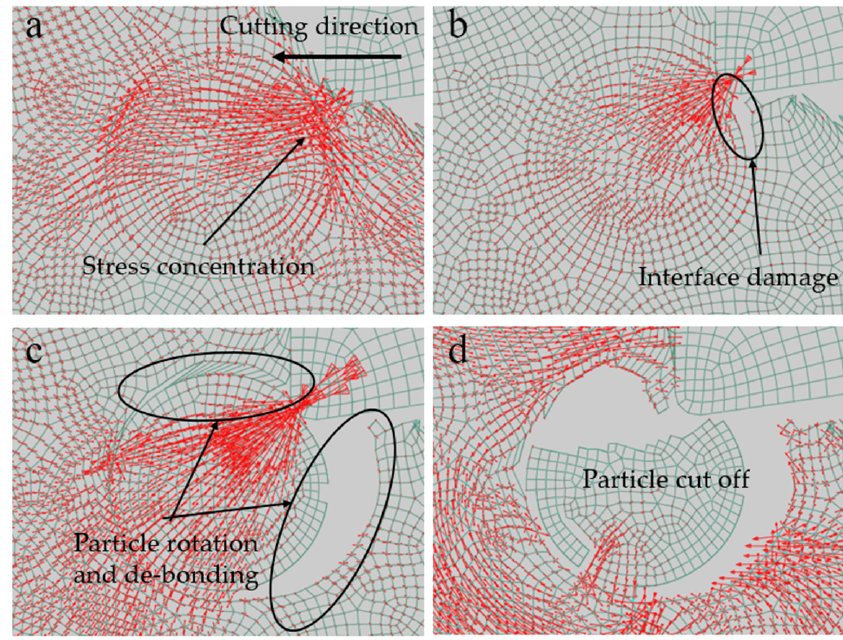
Figure 13. Stress evolution of UEVCT particle removal process. ( a – d ) is the stress of the particle at different moments during UEVCT.